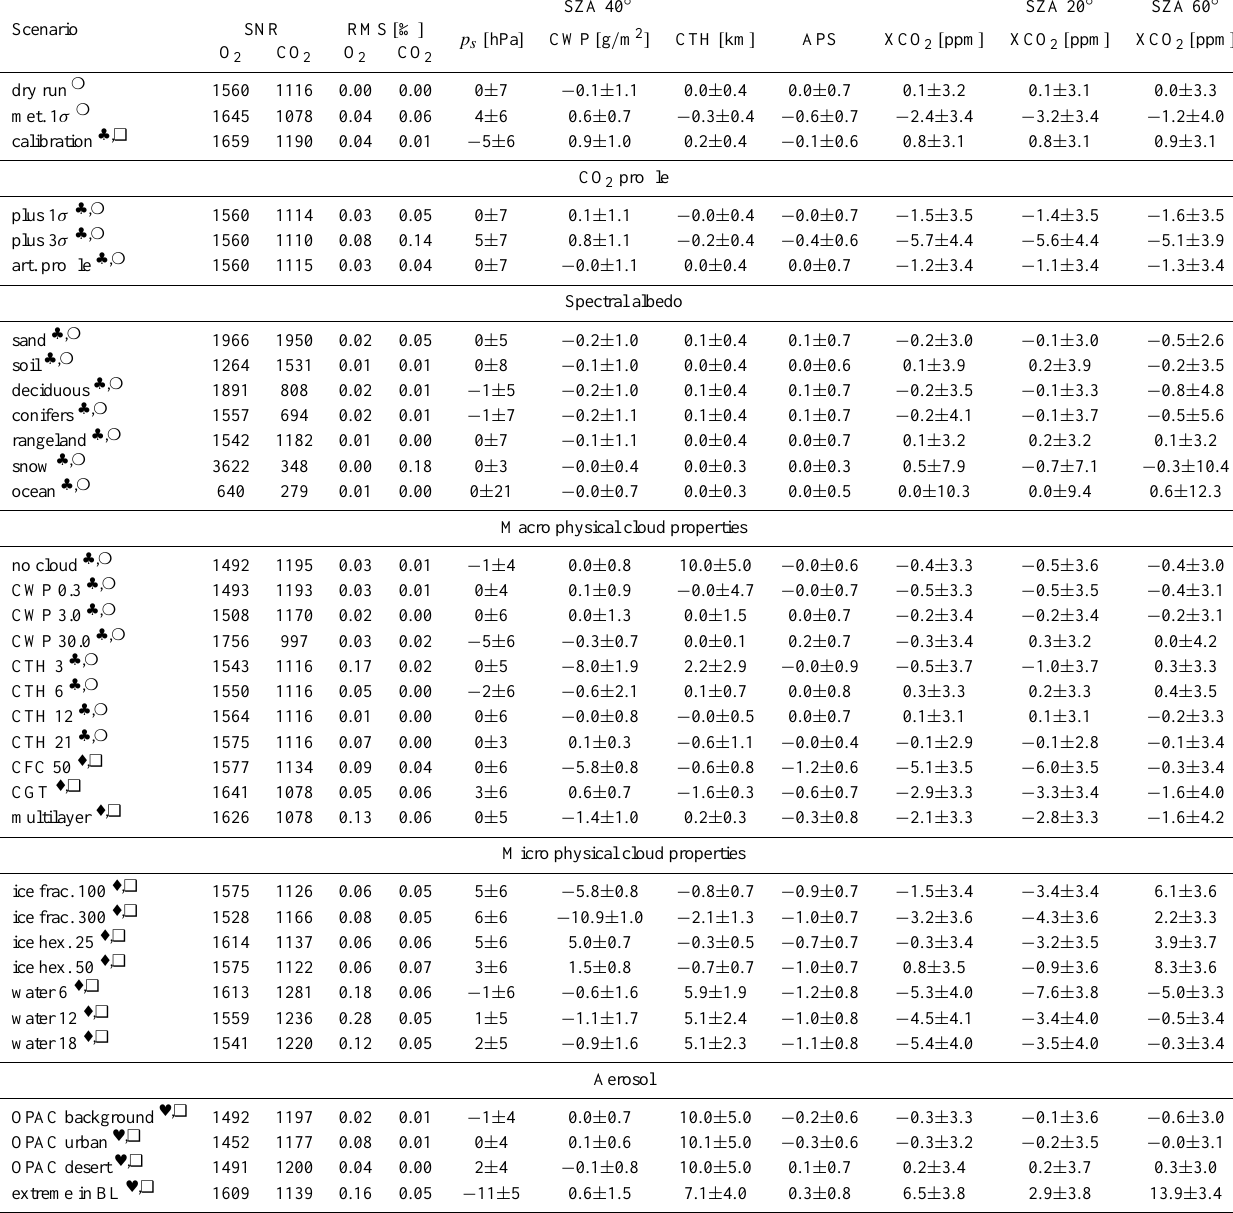
Table 2. Overview of the retrieval performance for 35 test scenarios based on SCIATRAN 3.0 simulations with a modified US-standard atmosphere. For all scenarios, we assume a Lambertian surface with an albedo which is spectrally constant 0 . 2 except for the “spectral albedo” scenarios. The table shows the average signal to noise (SNR) and the residuals relative root mean square (RMS) in both fit windows as well as the main retrieval errors of XCO 2 , scattering parameters (CWP, CTH, APS), and surface pressure. All errors are given with systematic error (bias) ±stochastic error. The scenarios are based on the “dry run” scenario ( ¤ ), the “met. 1 σ ” scenario ( ' ), and the “no cloud” scenario ( “ ). Some scenarios are intended to quantify the retrievals capability of reproducing modifications of state vector elements ( m ). The other scenarios are intended to additionally quantify the retrievals sensitivity to parameter vector elements ( q ) (i.e. to a imperfect forward